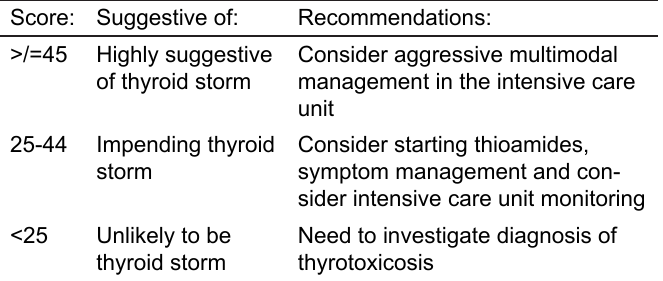
Table 4. Recommendations based on the Burch-Wartofsky point scale.